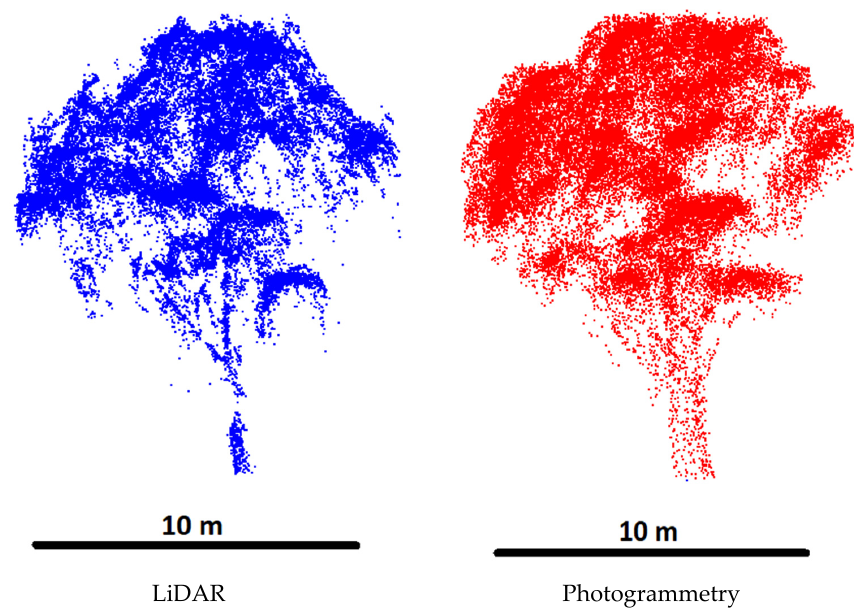
Figure 15. Side view of LiDAR and photogrammetric 3D points of a tree. Table 3. The difference between estimated tree canopy parameters using photogrammetric and LiDAR point clouds.